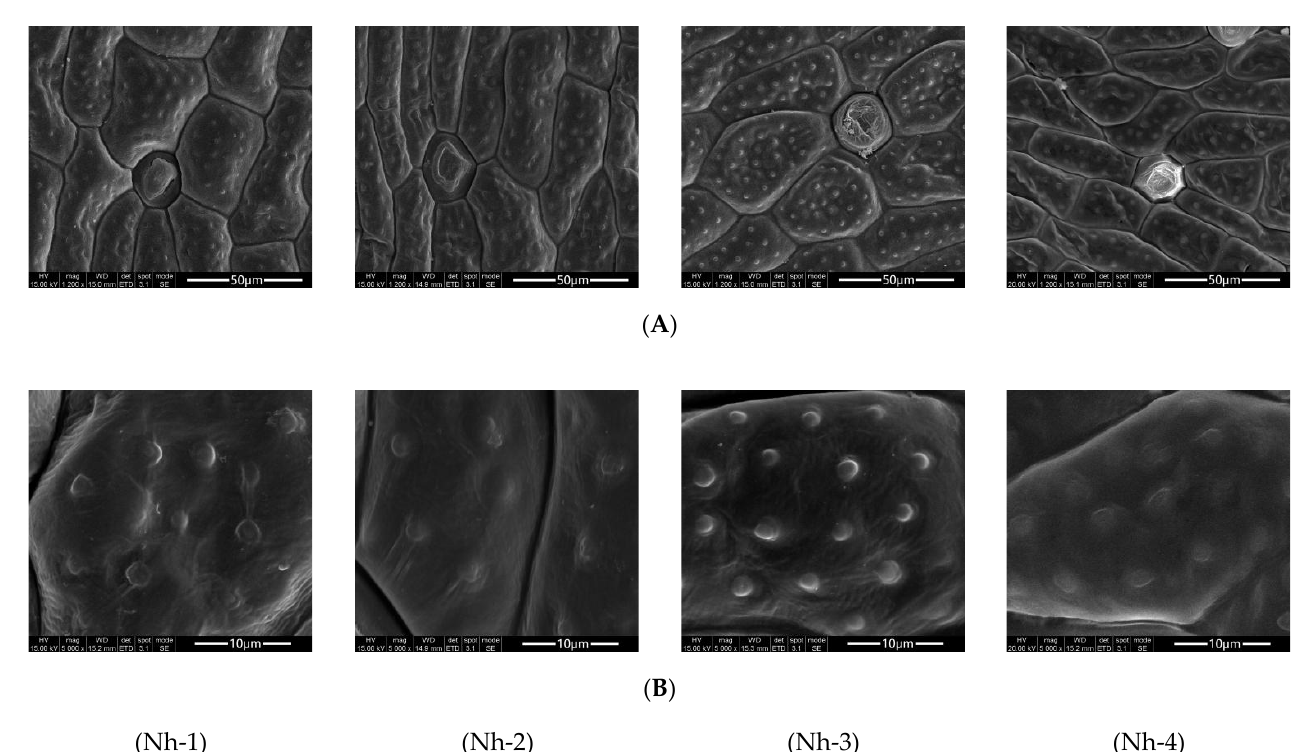
Figure 2. Microcosmic morphologies of the flower petals of N. hybrid observed by scanning electron microscopy (SEM). A : Epidermis of flower petals, bar = 50 μ m; B : papillae on the epidermis of flower petals, bar = 10 μ m. Nh ‐ 1, Nh ‐ 2, Nh ‐ 3, and Nh ‐ 4 represent blue ‐ purple, pink, yellow, and white types of N. hybrid , as they do in Figure 3 below.